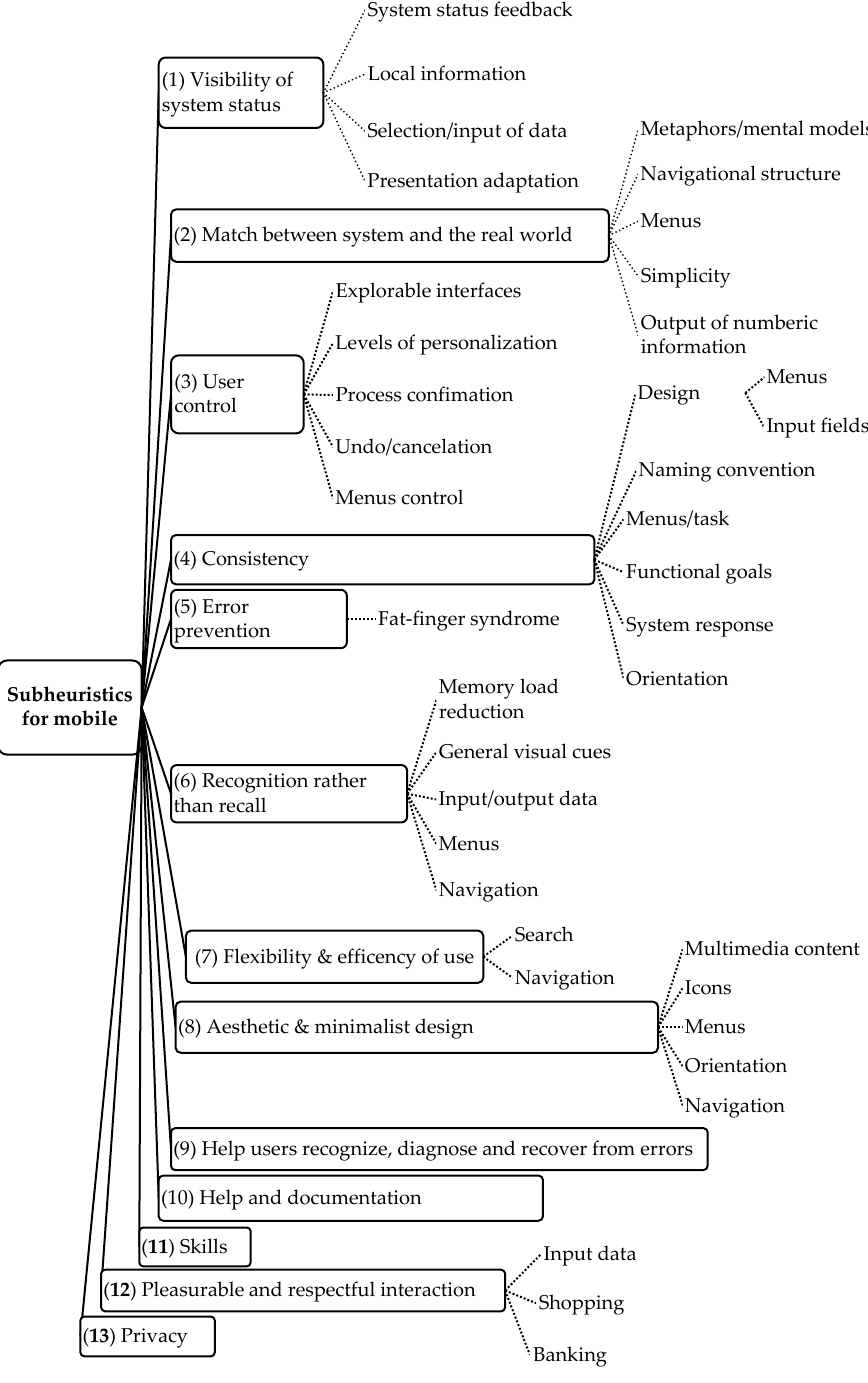
Figure 1. 13 sub-heuristics for mobile devices adapted from G ó mez